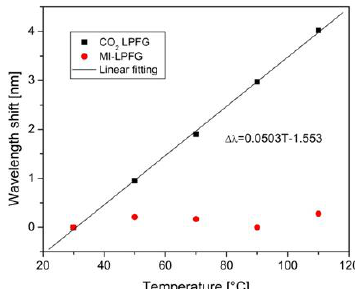
Figure 6. The wavelength shift of the main rejection bands of MI-LPFG and CO 2 LPFG versus applied temperature on CO 2 LPFG.